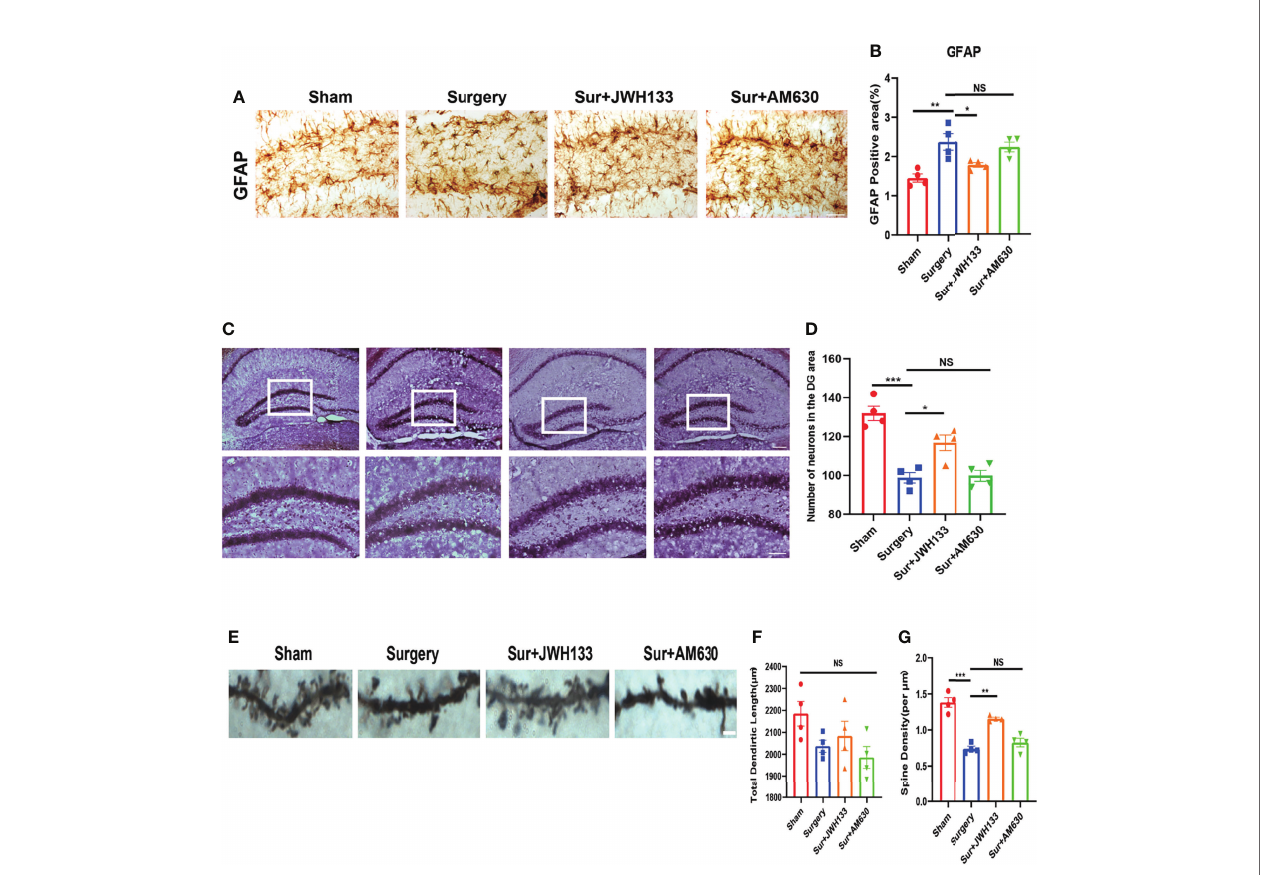
FIGURE 3 | (A, B) GFAP expression analyzed by immunochemistry in the hippocampal dentate gyrus brain region; statistical data depicted in the graph (means±SEM, n=4, scale bars=100 m m). Quanti fi cation of positive areas by using ImageJ. (C, D) Nissl staining of the hippocampus in (C) and statistical graph is shown in (D) (n=4, scale bars =200 m m and 100 m m). Examination of the hippocampus by Golgi – Cox staining (E – G) ; pictures analyzed with the NeuroJ plugin in ImageJ to calculate the total length of dendrites and the density of synaptic spines (means±SEM, n=4, scale bars=4 m m). NS means not signi fi cant, *P < 0.05, **P < 0.01, ***P < 0.001 compared with the corresponding group, as determined by